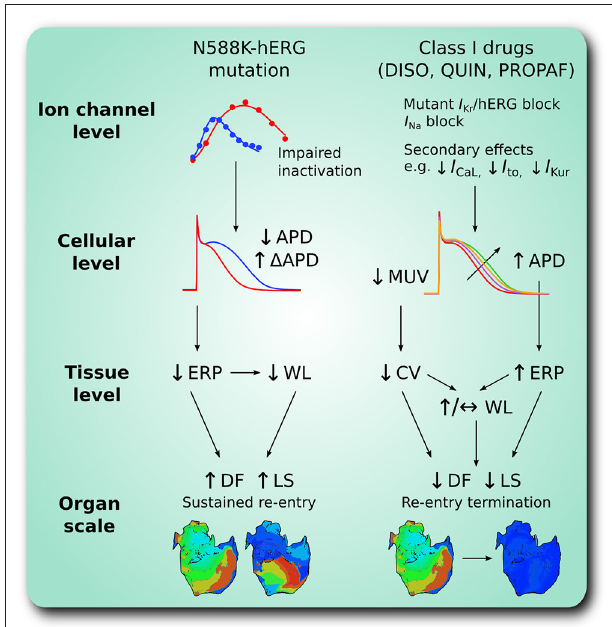
FIGURE 8 | A schematic summary of pro-arrhythmic effects of the N588K-hERG mutation in human atria and anti-arrhythmic effects of class I drugs. At the ion channel level, the N588K mutation impairs hERG channel inactivation, increasing I Kr which shortens the action potential duration (APD) at the cellular level, and increases its dispersion, 1 APD, between certain regions of the human atria. In tissue, shortened APD corresponds to shortened effective refractory period (ERP) and excitation wavelength (WL), promoting sustenance of arrhythmias at the organ scale through higher dominant frequency (DF) and lifespan (LS) of re-entry. Class I drugs disopyramide (DISO), quinidine (QUIN), and propafenone (PROPAF)